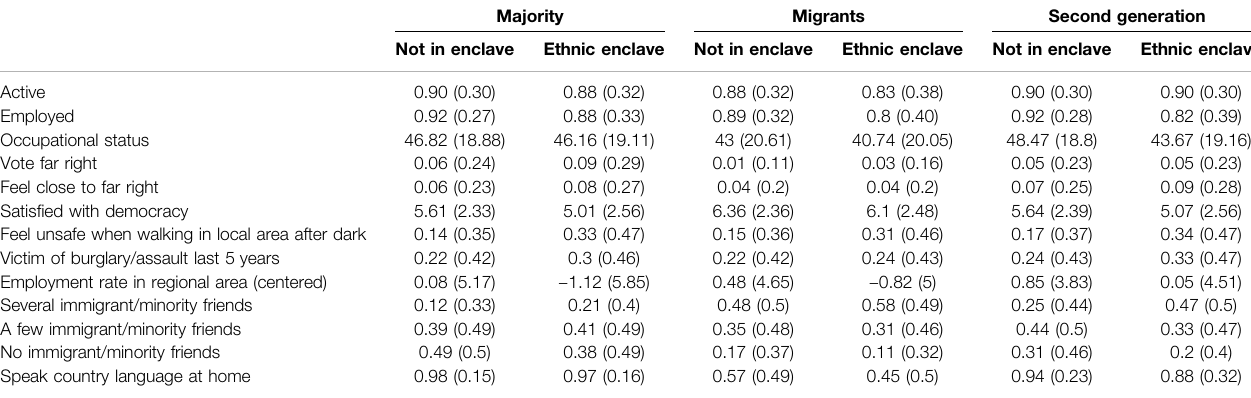
TABLE 1 | Average labor market and political outcomes for those living in ethnic enclave and those who do